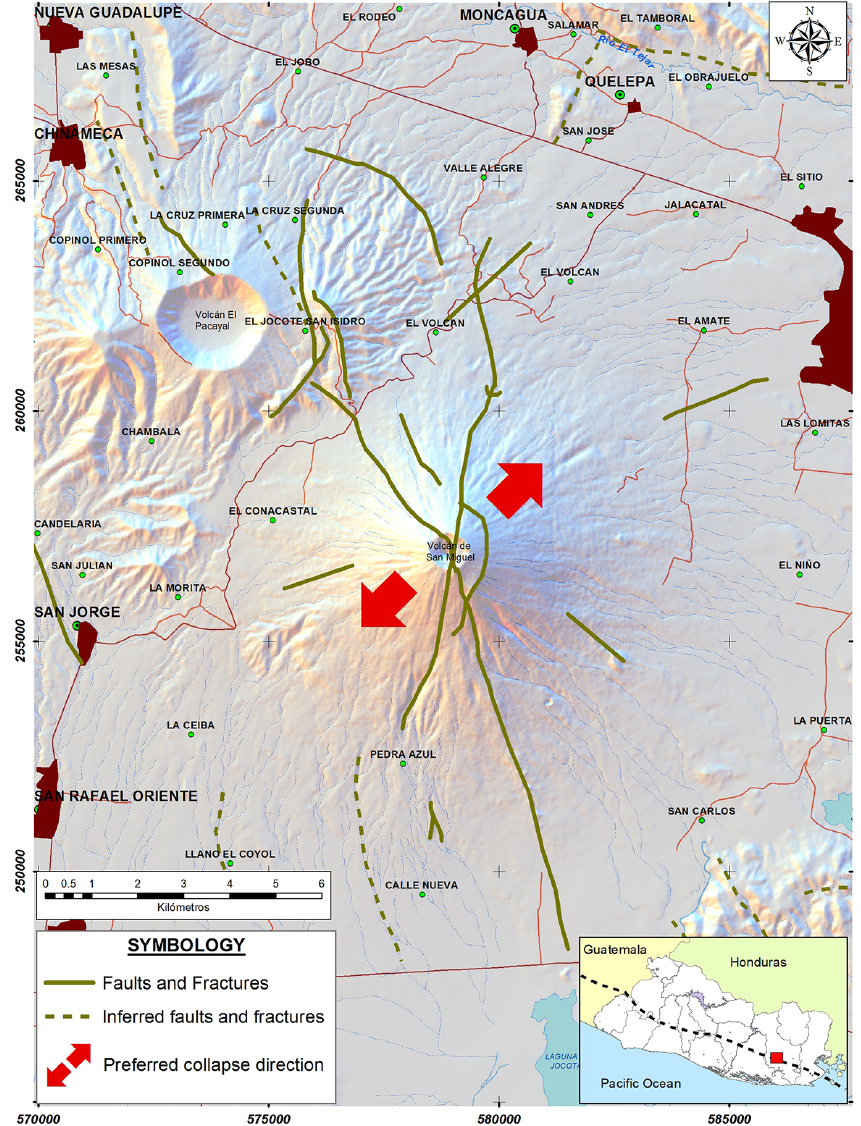
Figure 1. Tectonics and geodynamics of the San Miguel volcano. The SMFZ is identified with A. The triangles show the installed seismome- ters. The circles mark the historical eruptions. Red arrows indicate the possible collapse directions. Taken from Schiek